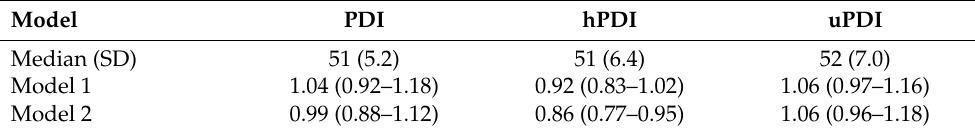
Table 3. Hazard ratios and 95% confidence intervals for incident type 2 diabetes according to a 10-point higher score of plant-based diet indices.